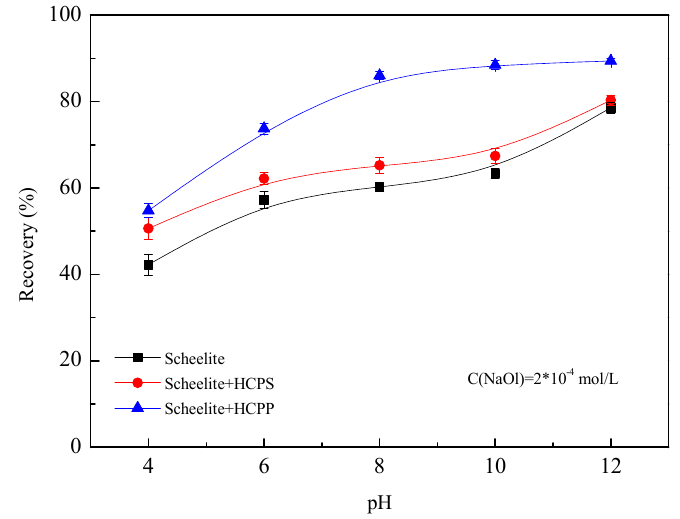
Figure 2. Flotation recovery of ultrafine scheelite with hydrodynamic cavitation (HC) treatments as a function of pH.